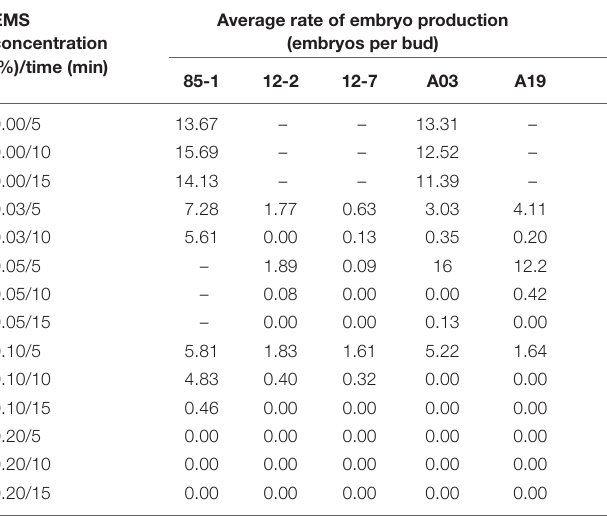
TABLE 1 | Average rates of embryo production from the microspore embryoids of five Chinese cabbage genotypes treated with different concentrations of EMS for different durations.